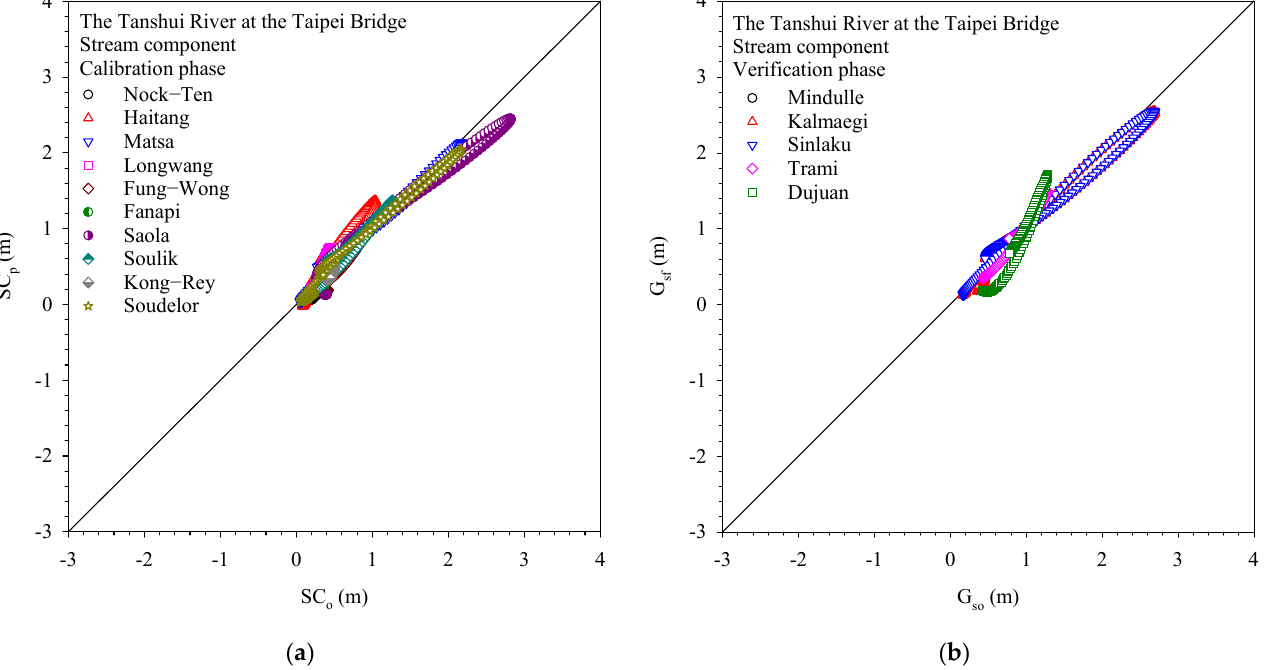
Figure 8. Accuracy of 1 h ahead stream component forecasting during typhoons: ( a ) Calibration phase; ( b ) Verification phase.